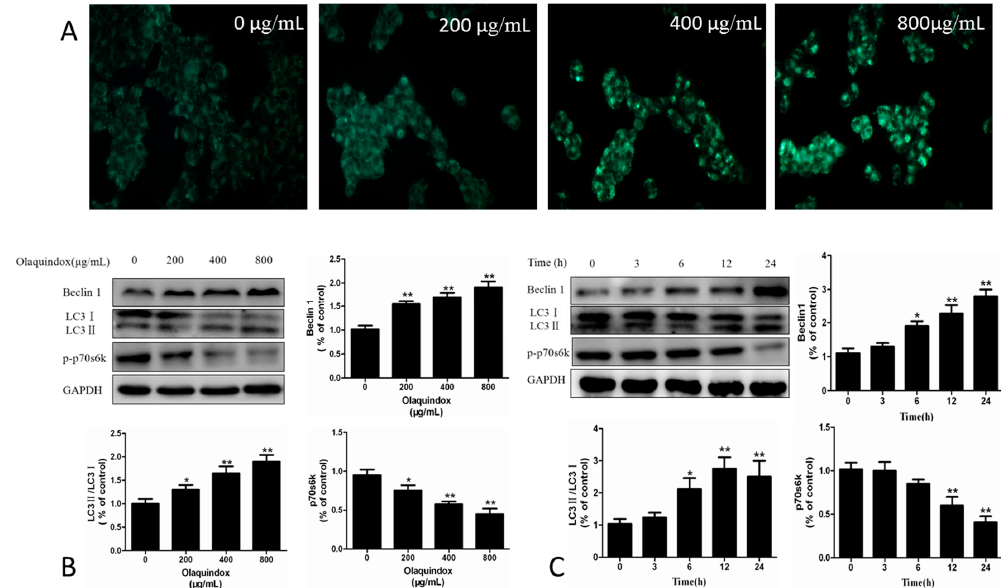
Figure 3. Effect of olaquindox on autophagy in HEK293 cells. ( A ) Autophagic vacuoles induced by olaquindox were stained with monodansylcadaverine (MDC). Cells were treated with olaquindox for 24 h, and then incubated with medium containing 50 μ M MDC for 30 min in the dark at 37 °C. Cells were observed under a Leica inverted fluorescence microscope (400×); ( B ) Expression of Beclin 1, LC3II/LC3I and p70s6k treated with olaquindox (0, 200, 400, 800 μ g/mL) for 24 h were detected by western blotting analysis, GAPDH was used for loading control; ( C ) Cells treated with 800 μ g/mL olaquindox for different time points (0–24 h) and expression of Beclin 1, LC3II/LC3I and p70s6k were detected by western blotting analysis. All data represents means ± SD from three independent experiments. * p < 0.05, ** p < 0.01, compared to the control group.